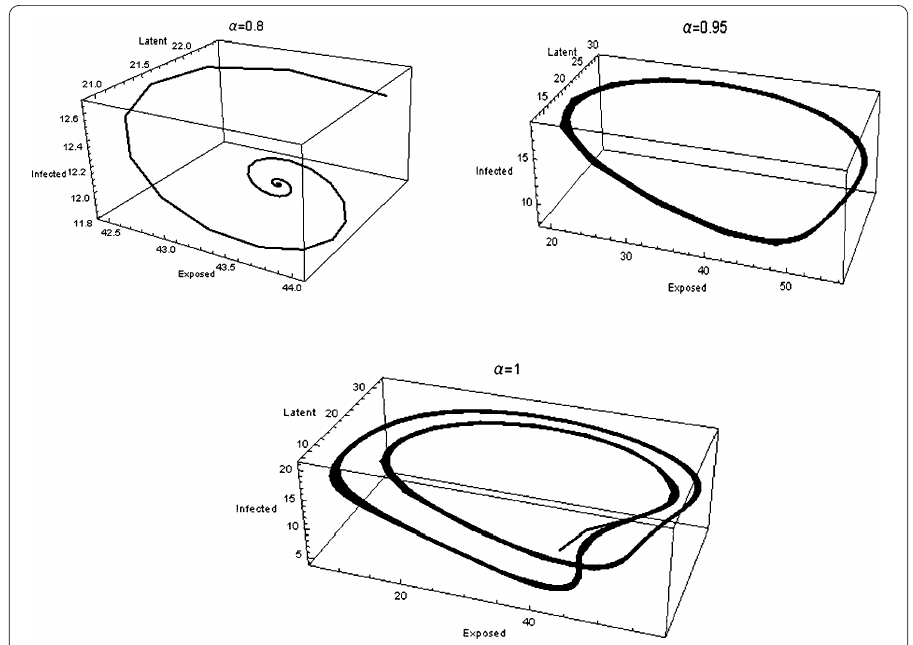
Figure 5 The phase diagrams of SVELITR at different values of α for R 0 > 1 and τ = 1.5 > τ 0